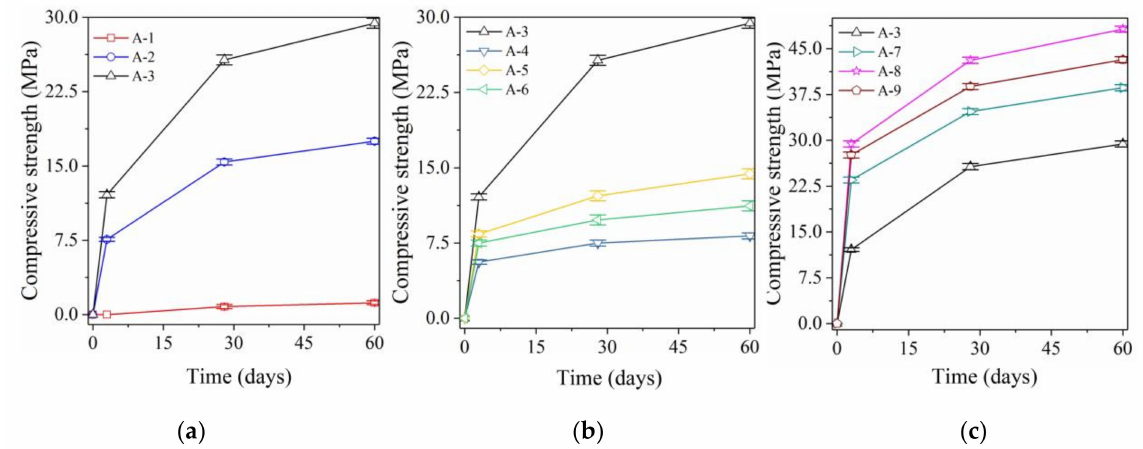
Figure 1. Compressive strength of samples excited by different initiator. ( a ) Excited by NaOH; ( b ) excited by sodium silicate; ( c ) excited by both NaOH and sodium